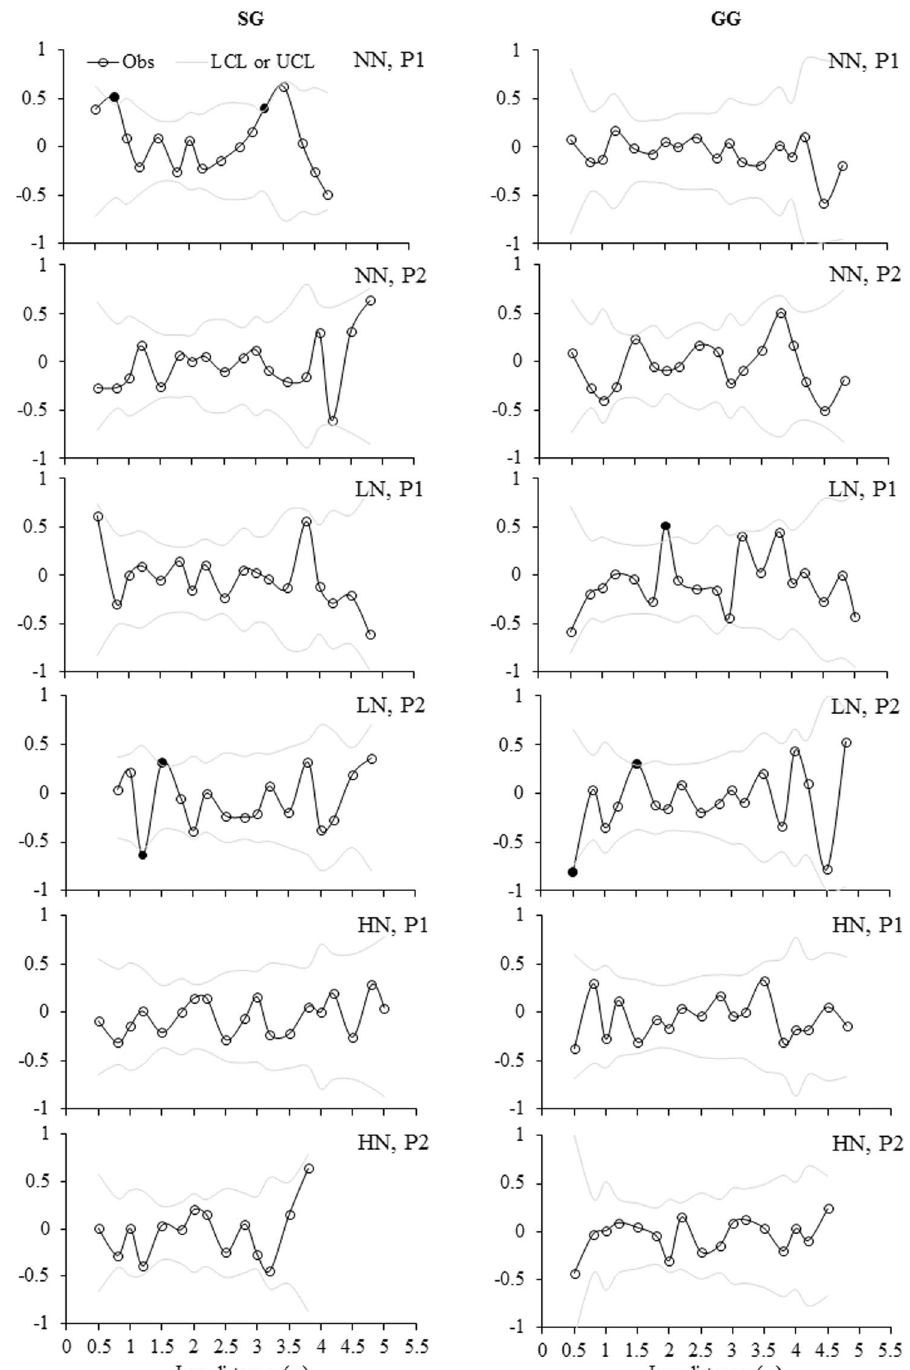
Figure 5. Moran’s I correlograms for soil MBC concentration under three N fertilization treatments (i.e. NN, LN and HN) in SG and GG cropland soils in a three-year long fertilization experimental site at the Tennessee State University (TSU) Agricultural Research Center in Nashville, TN, USA. Filled circles denote Moran’s I values that exhibited significant positive or negative autocorrelation. Obs: observations; LCL: low confident limit; and UCL: Upper confidence limit. Other abbreviations are referred to Table